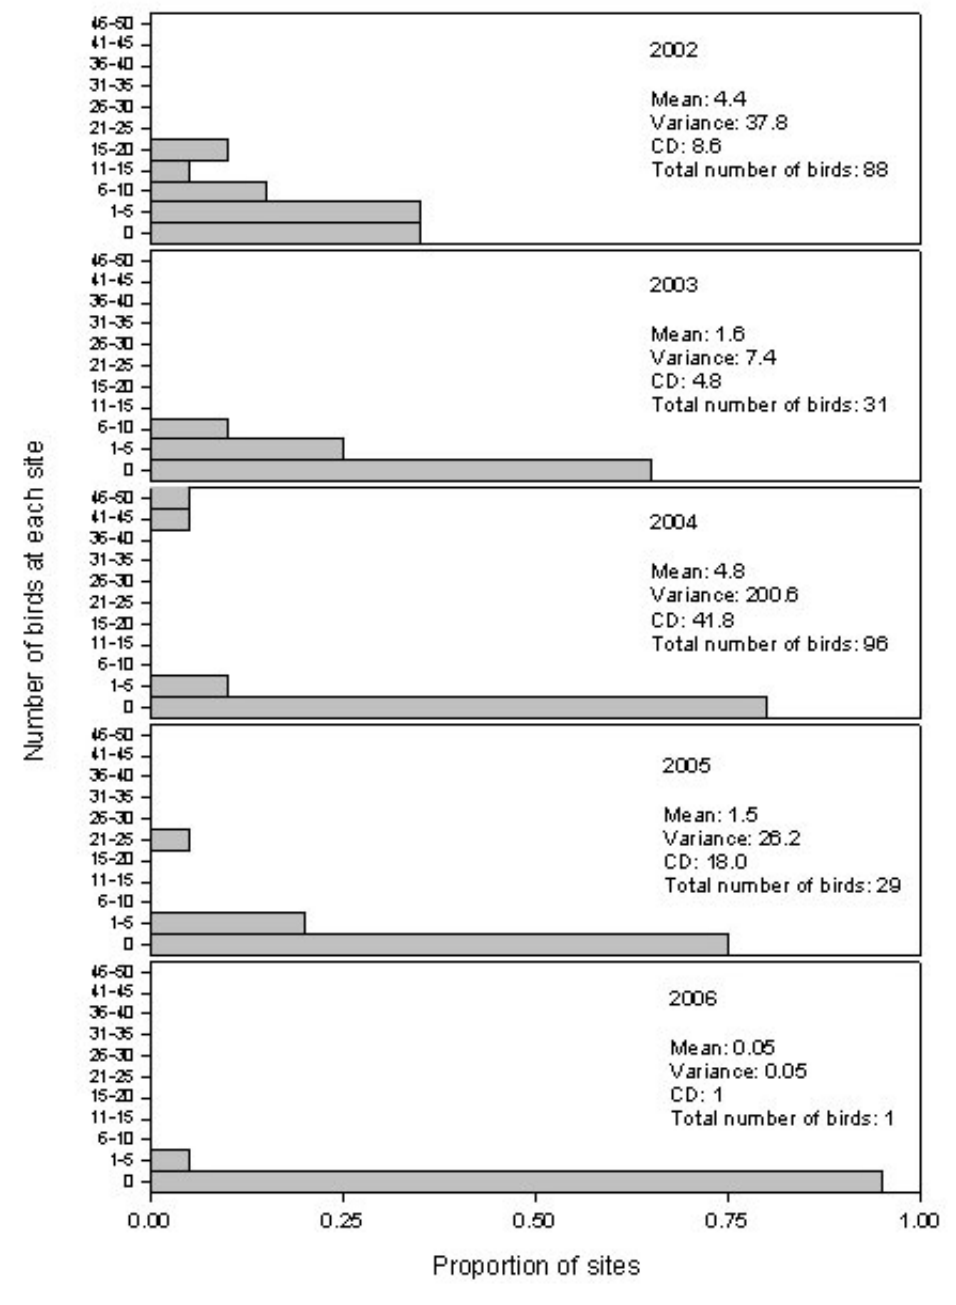
Fig. 2. Colony size distributions and descriptive statistics for Ivory Gull nesting on Devon Island and southern Ellesmere Island in 2002–2006. Only colonies that were counted every year were included ( n = 20). CD is the coefficient of dispersion (variance to mean